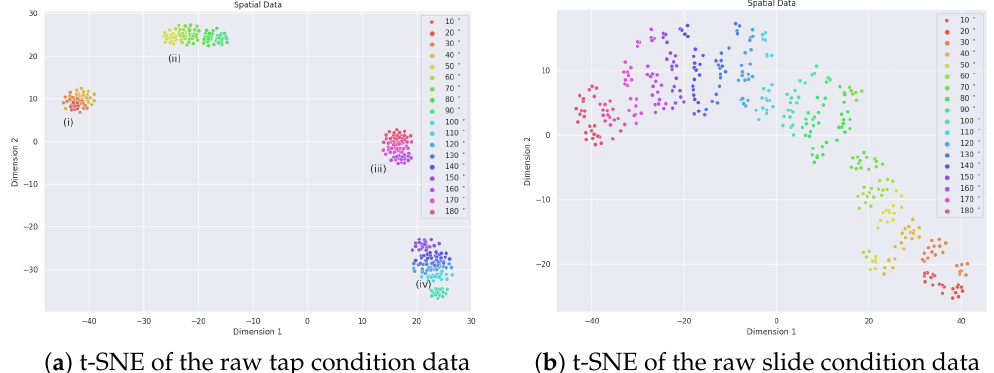
Figure 5. t-SNE of the spatial distribution of spikes in the raw data for tapping ( a ) and sliding ( b ) over the range of edge orientations (0–170 ◦ in steps of 10 ◦